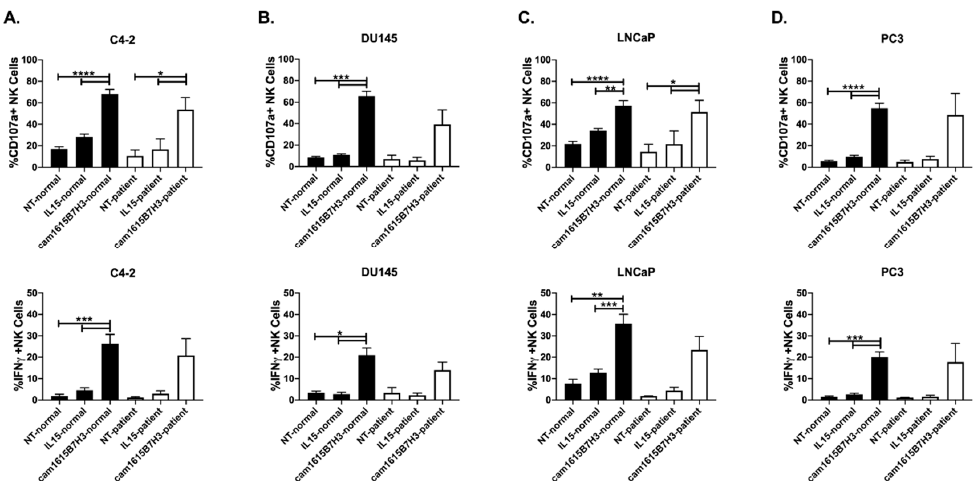
Figure 4. cam1615B7H3 TriKE enhances NK cell function of healthy donors (black bars) and prostate cancer patients (white bars) against prostate tumor targets. Pooled analysis of proportion of NK cells from healthy donors or prostate cancer patients expressing CD107a+ (top) or IFN γ (bottom) against